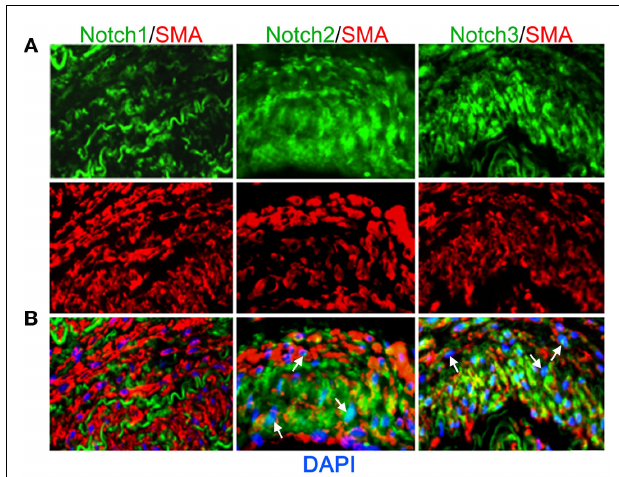
stimulated cells was significantly reduced in comparison to Fc control plated cells (B) . (Green = BrdU positive nuclei, Blue = DAPI for total cell count, n = 15, p < 0.01). Reduction of Notch3 levels via siRNA-mediated knockdown (C) reveals a distinct reduction in endogenous SM-actin levels after 72h as compared toVSMC receiving a non-targeting control probe (D) .